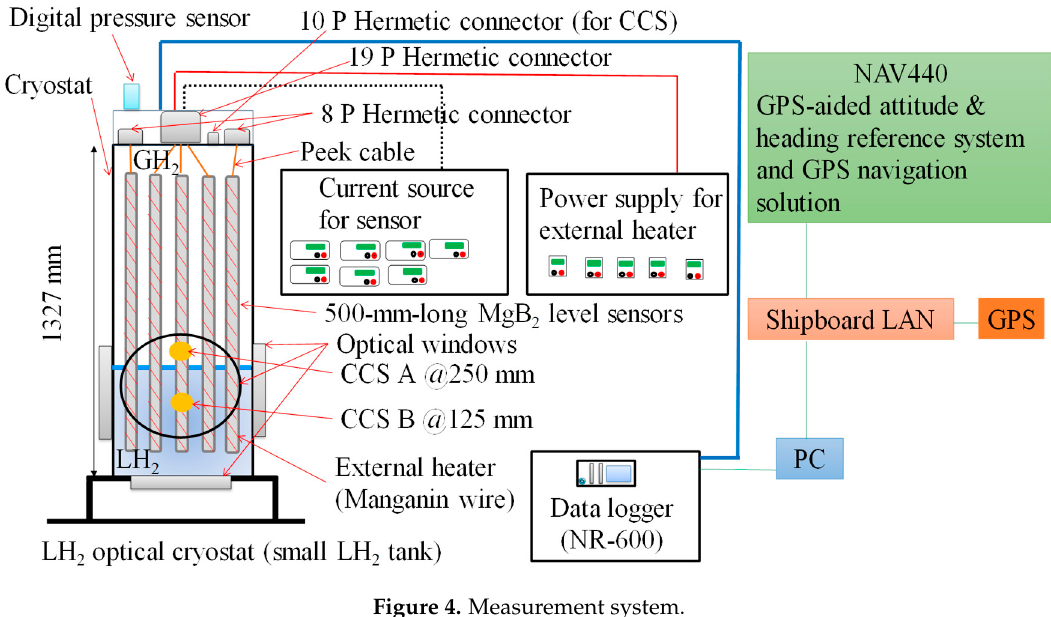
Figure 4. Measurement system.